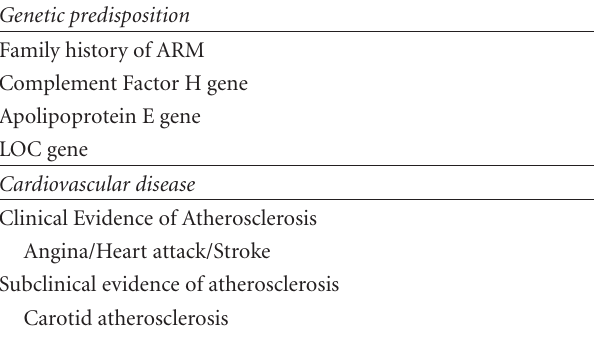
Table 2: Risk factors for ARM examined in the cited